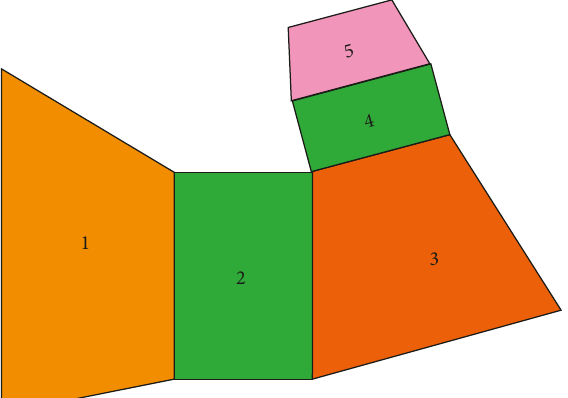
Figure 8: A combined surface with large and small curvatures.